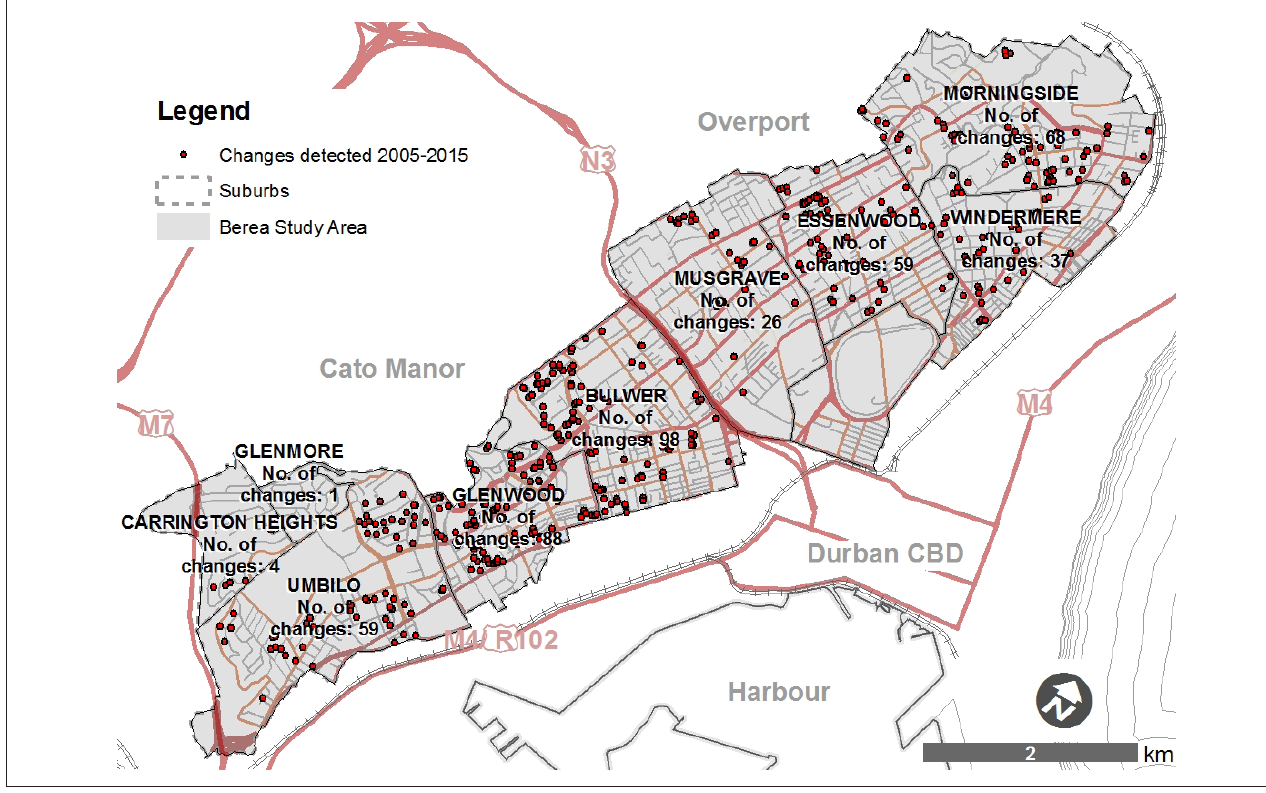
Figure 3: Distribution of floor area changes between 2005 and 2015 Source: Adapted from eThekwini Municipality Central Durban Application Register by DUT GIS Unit, 2016